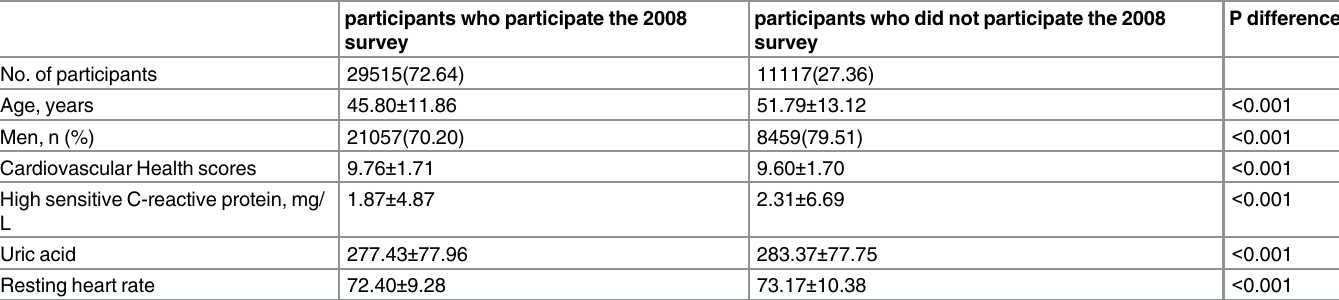
Table 2. Clinical Characteristics in 2006 according to the participants who participated or not participated the 2008 survey. participants who participate the 2008